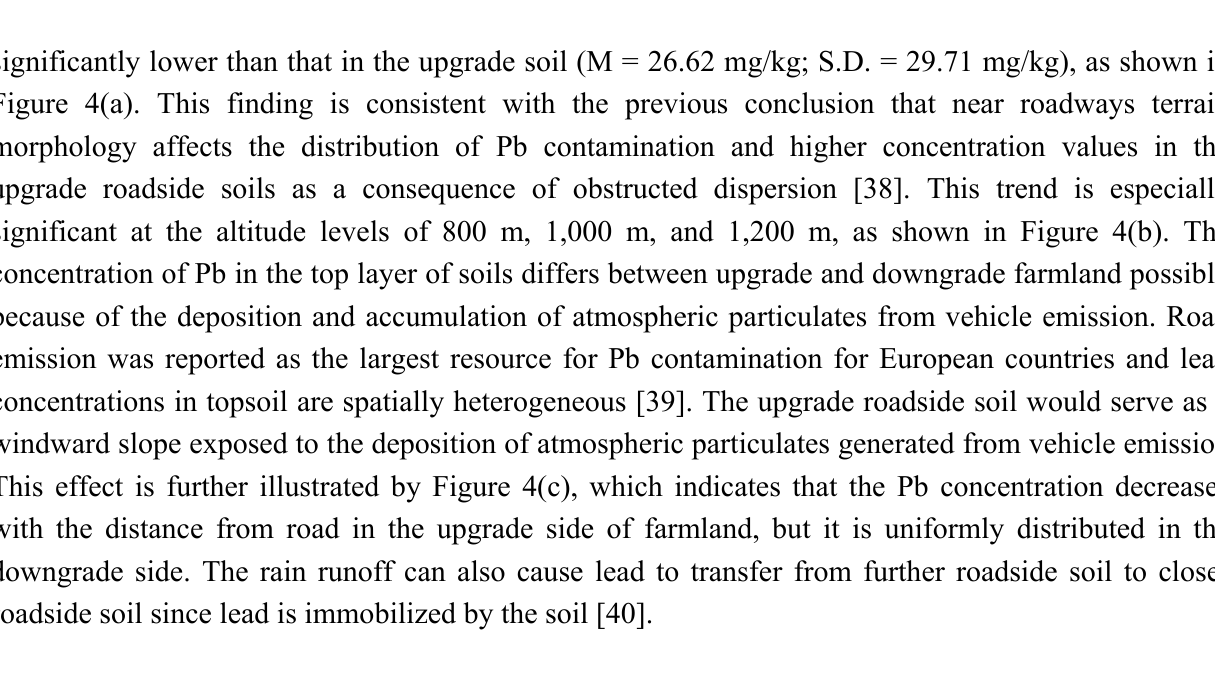
Figure 4. Variation in soil heavy metal concentrations with